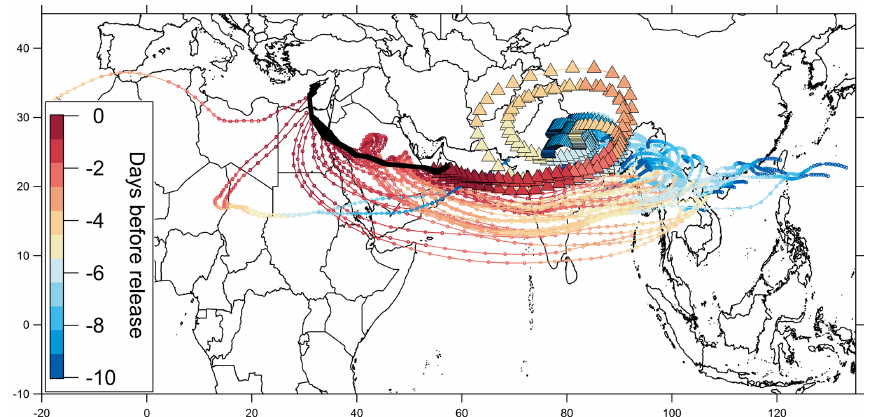
Figure 5. Centroid trajectories for flight 19 (13 August 2015) with colour-coded transport time. Triangles represent back trajectories for CH 4 mixing ratios above the CH 4 threshold, and circles represent back trajectories for CH 4 mixing ratios below the CH 4 threshold.